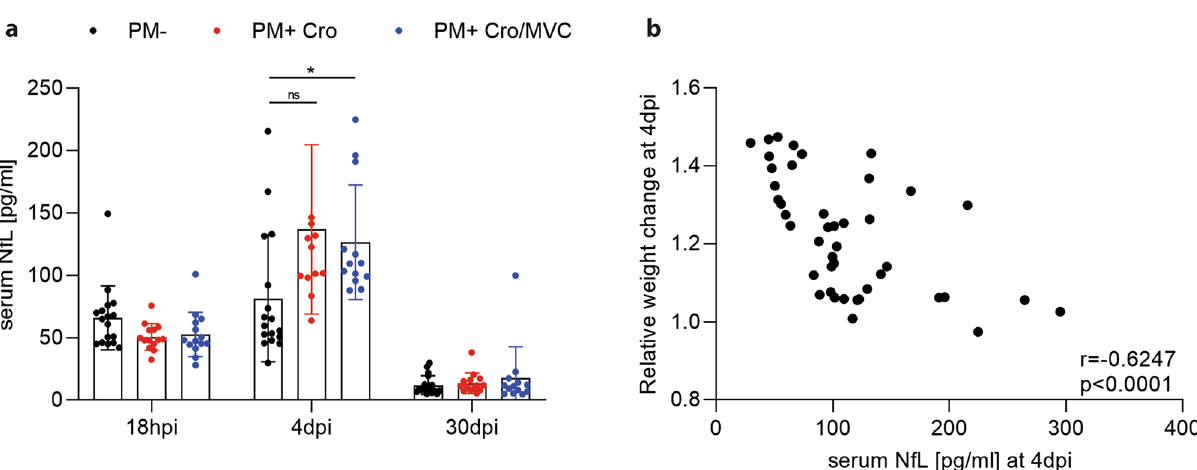
Figure 4. Neurofunctional outcome of PM. MVC treatment did not enhance learning/memory performance (PM- n = 16–20; PM + Cro n = 11–15; PM + Cro/MVC n = 11–16, depending on timepoints) ( a ) or improve hearing capacity (PM- n = 20; PM + Cro n = 14; PM + Cro/MVC n = 17) ( b ) in infected animals compared to vehicle treatment. Analysis of SGNs also revealed no reduced loss upon treatment with MVC (PM- n = 13–15; PM + Cro n = 7–10; PM + Cro/MVC n = 11–13, depending on timepoints) ( c ). Data are presented as mean ± SD if not stated otherwise. * p < 0.05, ** p < 0.01, *** p < 0.001, and **** p < 0.0001 (Mann–Whitney test for hearing threshold; Two-way ANOVA for SGN).